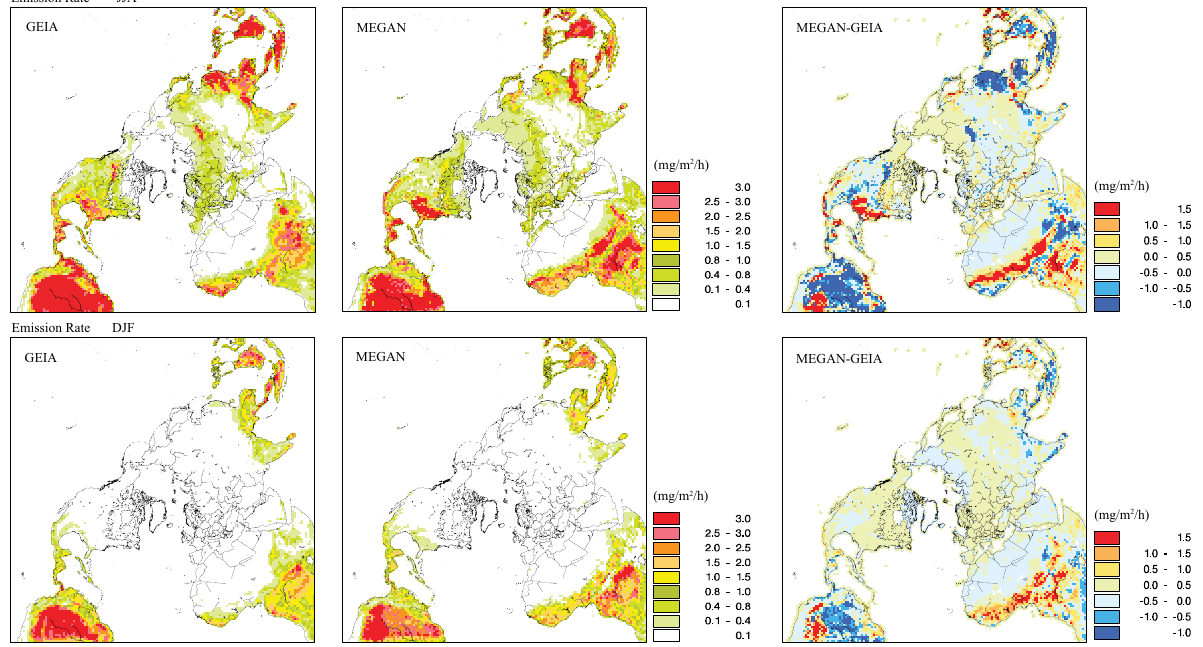
Fig. 6. Seasonal isoprene emission rates, estimated by MEGAN and GEIA together with their differences, for summer (JJA) and winter (DJF),